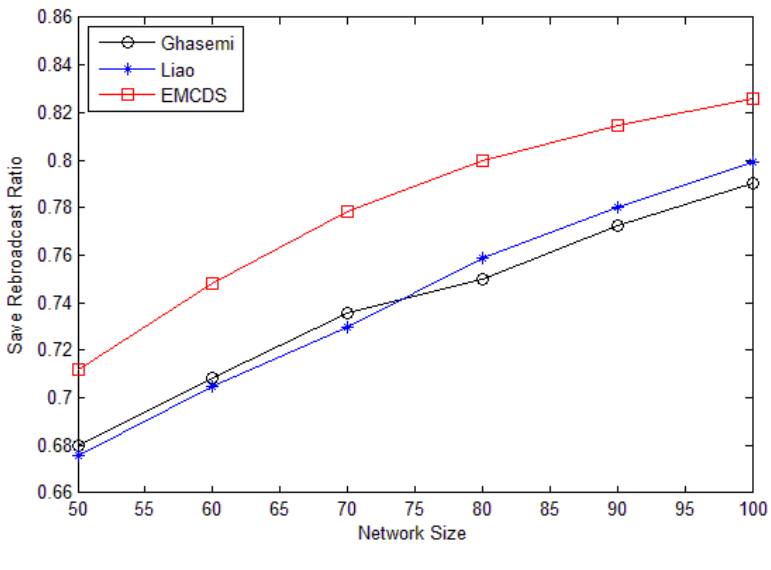
Figure 10. Saved rebroadcast with different number of